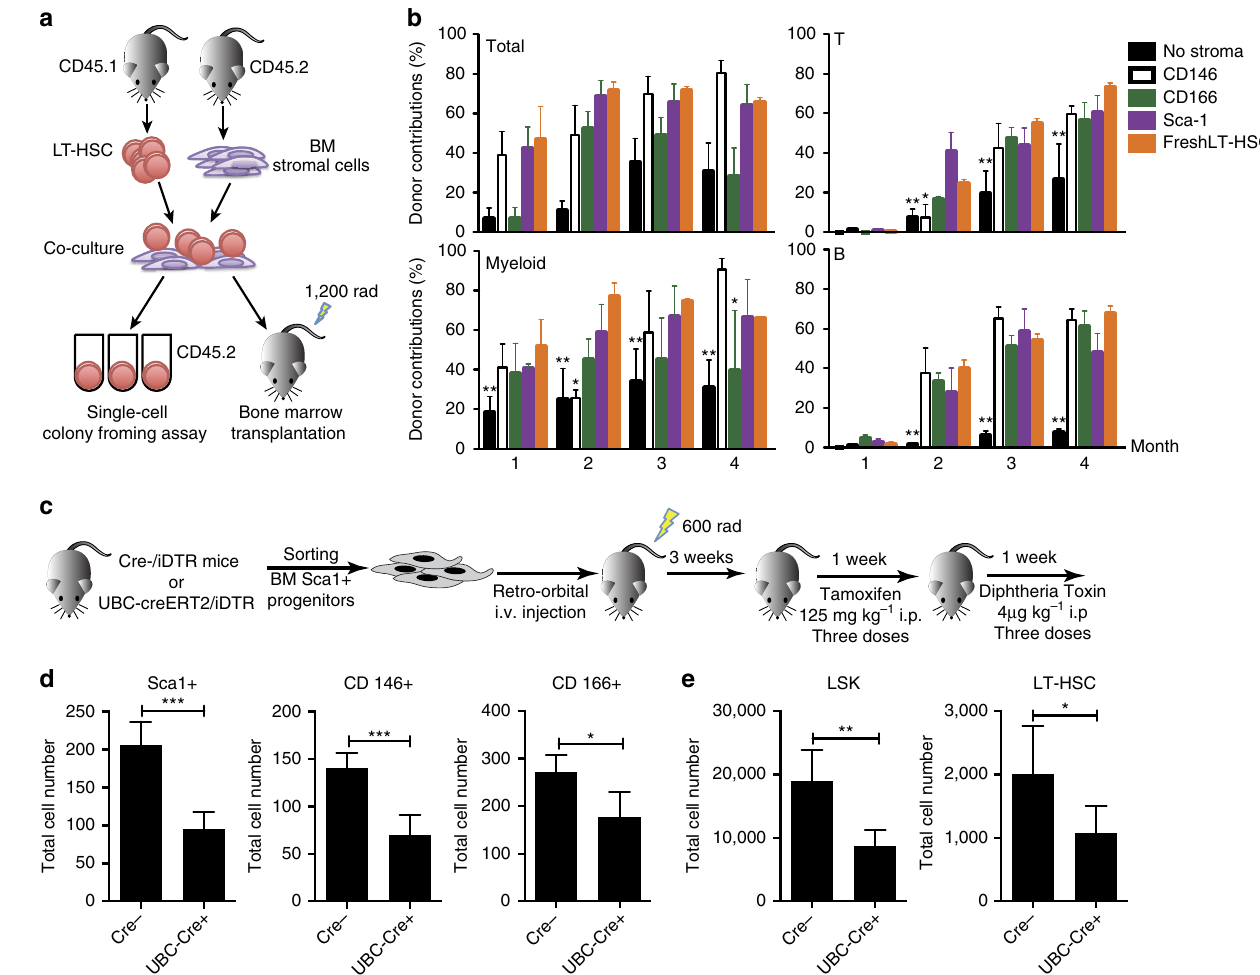
Figure 6 | Bone-disassociated mesenchymal progenitors support HSC maintenance in vitro . ( a ) LT-HSCs were cultured with mesenchymal progenitors for two days, then analysed for single-cell conlony forming ability or competitive repopulation. ( b ) Contribution of donor HSCs in the blood assayed 1–4 months after transplantation ( n ¼ 8). ( c ) Sca1 þ mesenchymal progenitors from Cre (cid:2) /iDTR or UBC-creERT2/iDTR mice were i.v. injected into mice and then ablated by tamoxifen injection. ( d – e ) FACS analysis of ( d ) the mesenchymal stromal progenitor population and ( e ) the LSK and LT-HSC populations directly after ablation of Sca1 þ mesenchymal stromal cells Cre (cid:2) n ¼ 4 and Cre þ n ¼ 5 from two combined experiments. (For b and e ; * P r